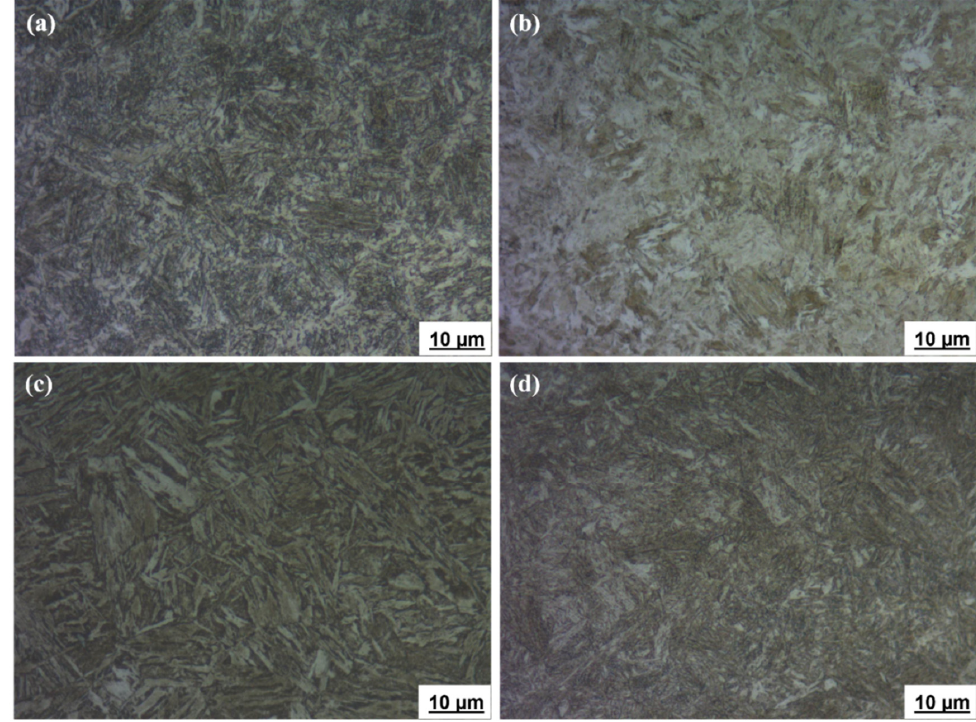
Figure 1. Optical microstructures of ballistic steel samples: ( a ) LT-1; ( b ) LT-2; ( c ) HT-1; ( d ) HT-2.